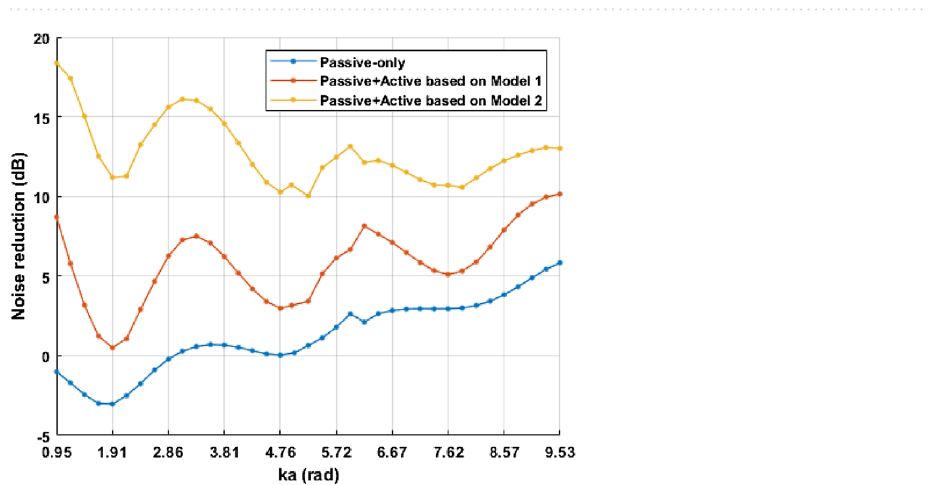
Figure 7. Noise reduction of circular barrier (blue), circular active noise barrier using the control filter obtained through the circular control source (red), and circular active noise barrier using the proposed theoretical model- based control filter